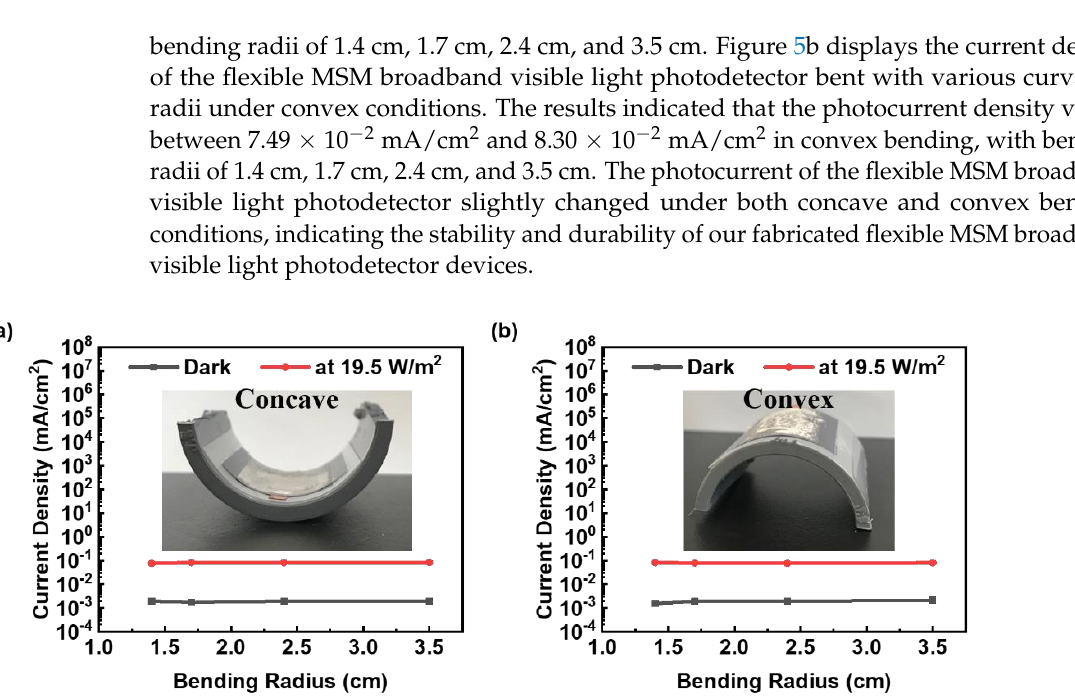
Figure 5. The current density of the flexible MSM broadband visible light photodetector bent with various curvature radii in ( a ) concave and ( b ) convex conditions.